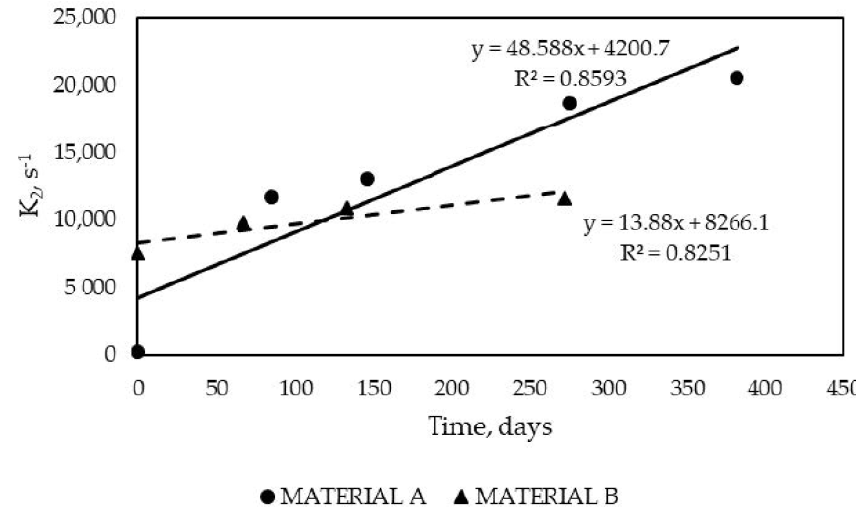
Figure 5. The value of the K 2 coefficient depends on the working time and the type of bag. The obtained results indicate that the type of filter material used plays a vital role among the factors influencing the filtration resistance in a dedusting installation. For the tested installation, bags made of material B are characterized by lower values of the dust resistance coefficient during long-term use.